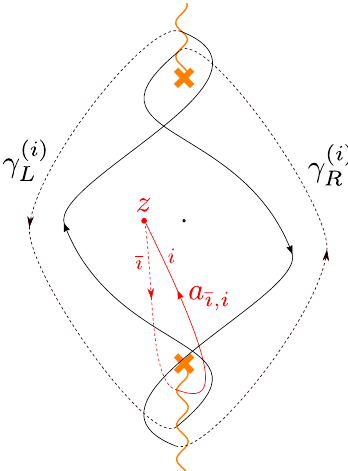
Figure 7. Cycles of BPS states for a surface defect near a puncture. Each closed cycle represents a 4d BPS particle, the open path is a 2d-4d BPS soliton for the surface defect at z 2 C . Solid lines run on sheets labeled by i while dashed lines run on sheets labeled by (cid:22) {